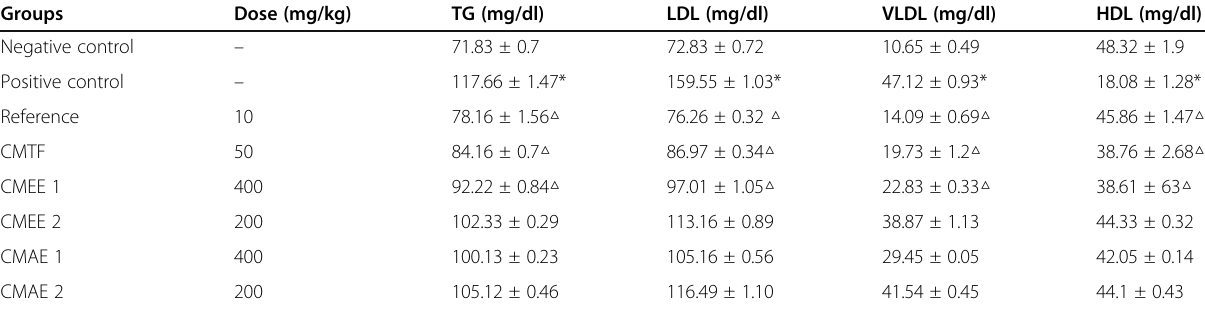
Table 4 Antihyperlipidemic activity of C. melo fraction and extracts